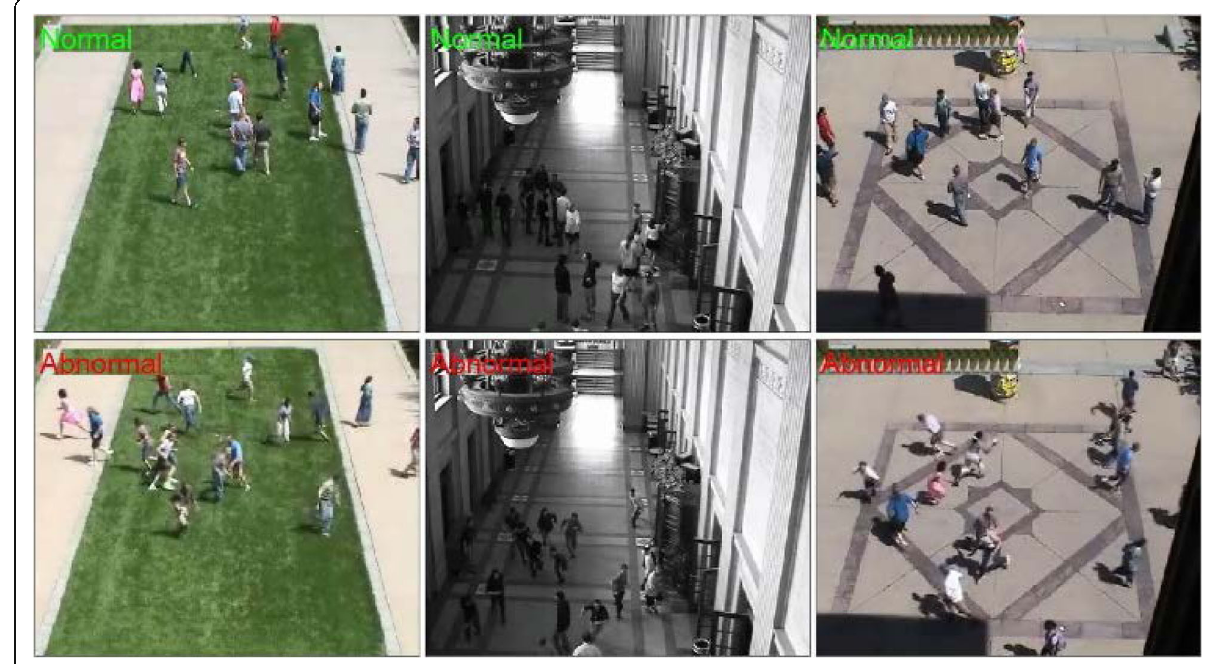
Fig. 7 Examples of detection results for global abnormal event detection from the UNM